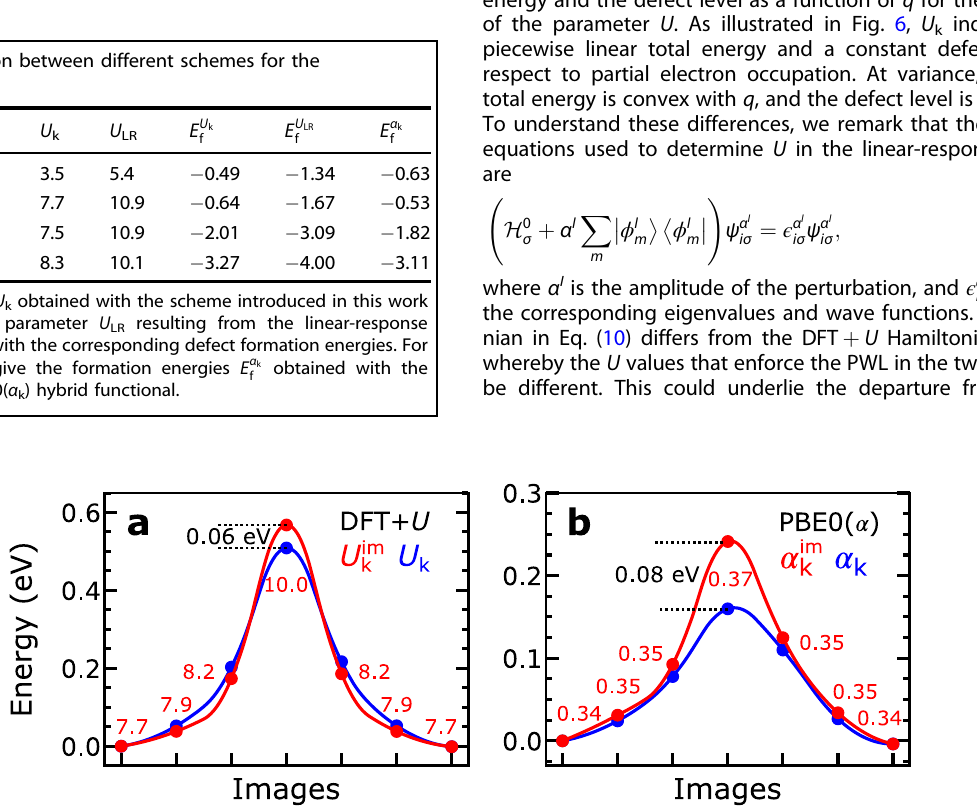
in DFT + U calculations, and ( b ) with fi xed α k and image-dependent α im k and α im for individual images are given. k k